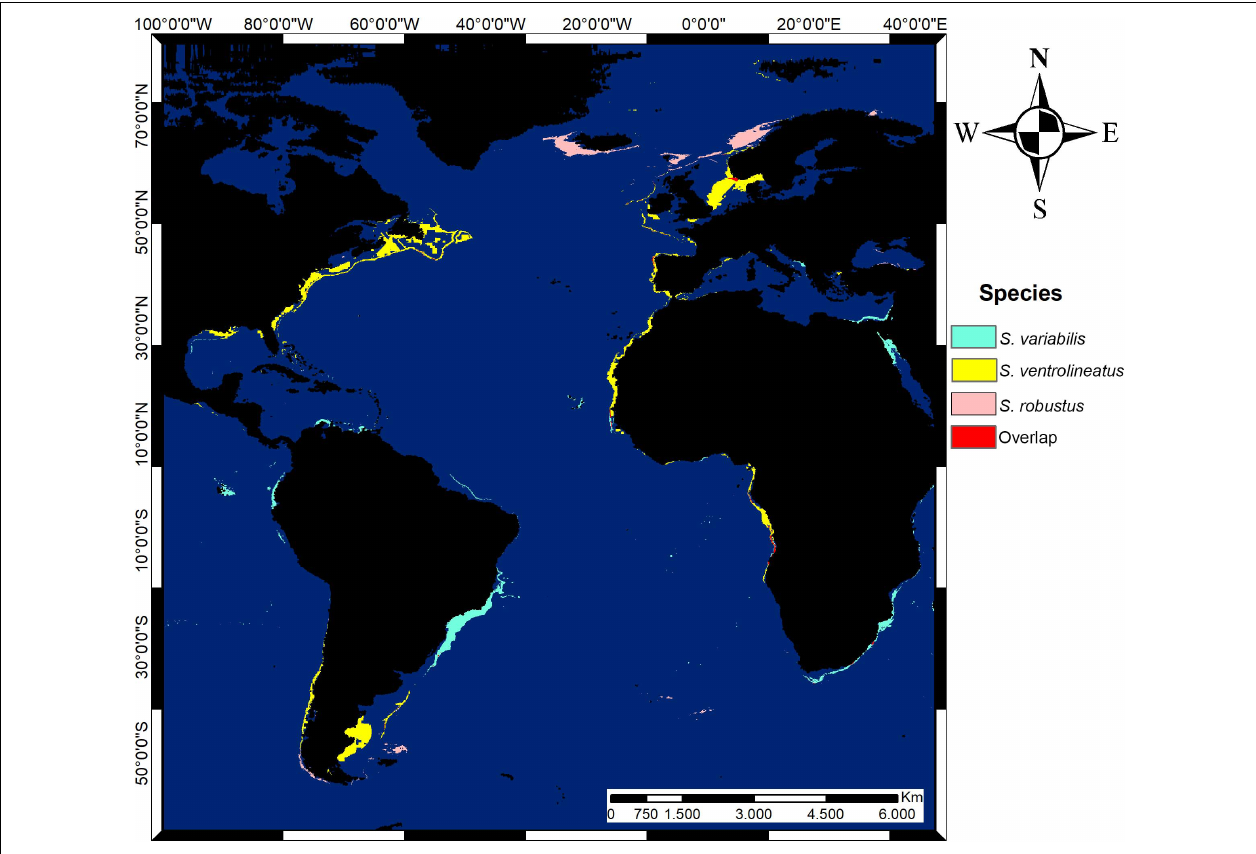
FIGURE 7 | Potential distribution map of suitable areas of Scutopus species in the Atlantic Ocean in thresholded format (10 percentile training presence). Overlapping areas of estimated species distribution are in